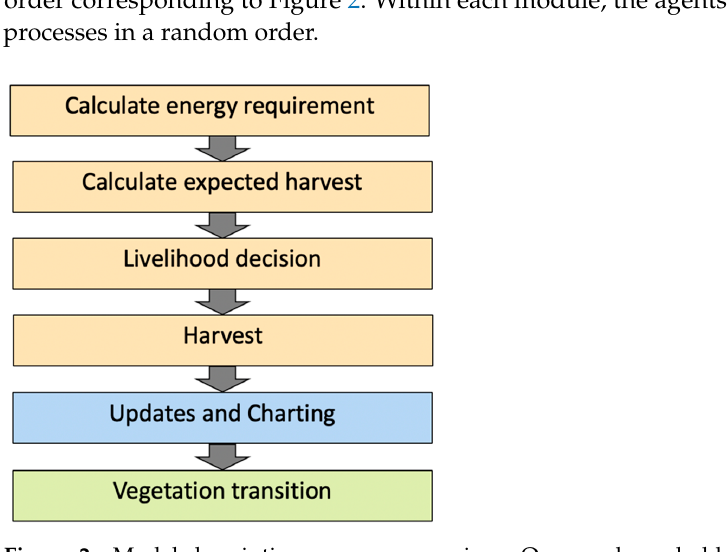
Figure 2. Model description: process overview. Orange: household agent procedures, green: land- scape agent procedures, blue: general procedures. landscape agent procedures, blue: general